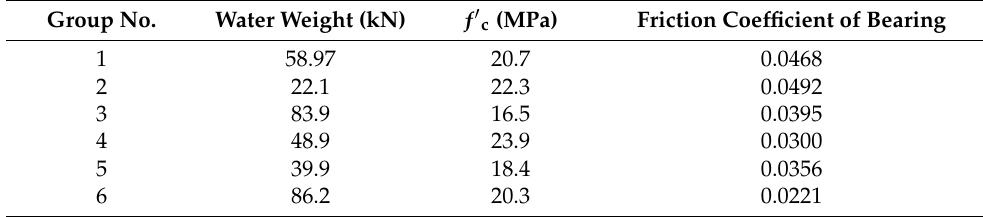
Table 3. Latin hypercube sampling